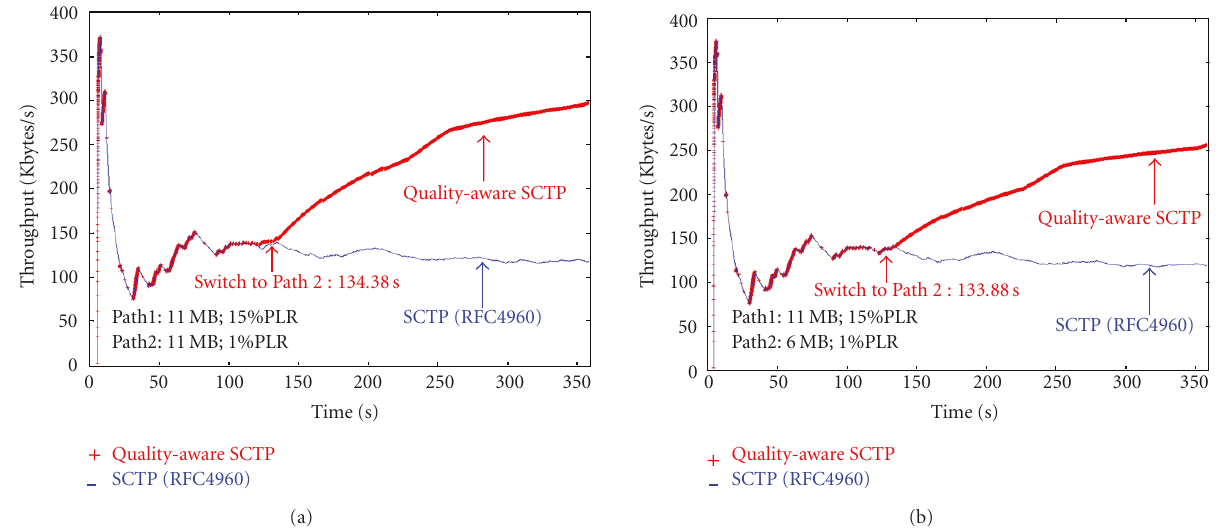
Figure 14: QA-SCTP path condition measure/switch experiment